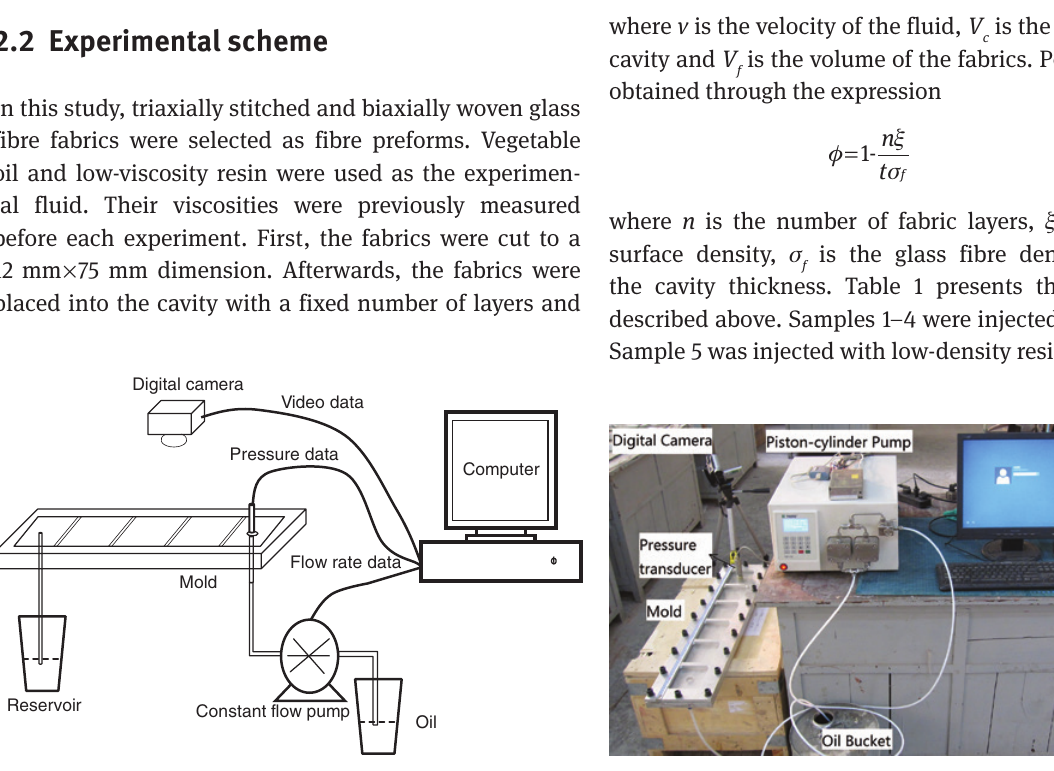
Figure 3: Schematic of experiment. Figure 4: Schematic of 1D controlled flow